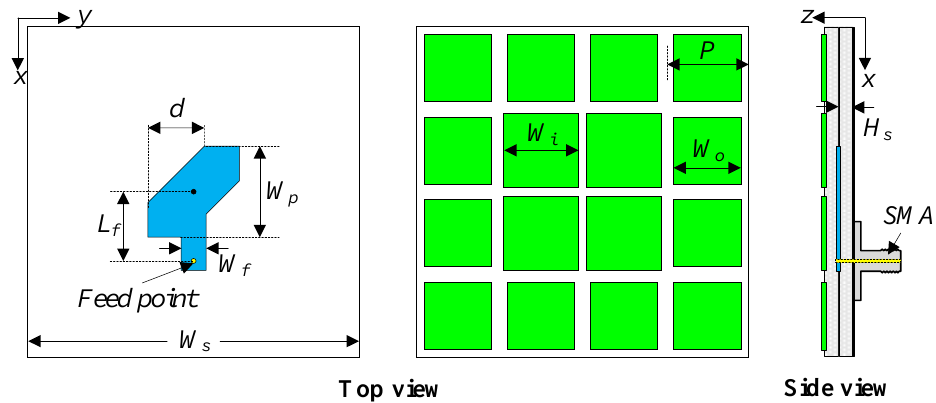
Figure 1. Geometry of the proposed wideband circularly polarized (CP) antenna. The optimized dimensions are as follows: W s = 40, H s = 1.52, W p = 11, d = 6.8, L f = 8.5, W f = 3, p = 10, W i = 9.0, W o = 8.1 (unit: mm).